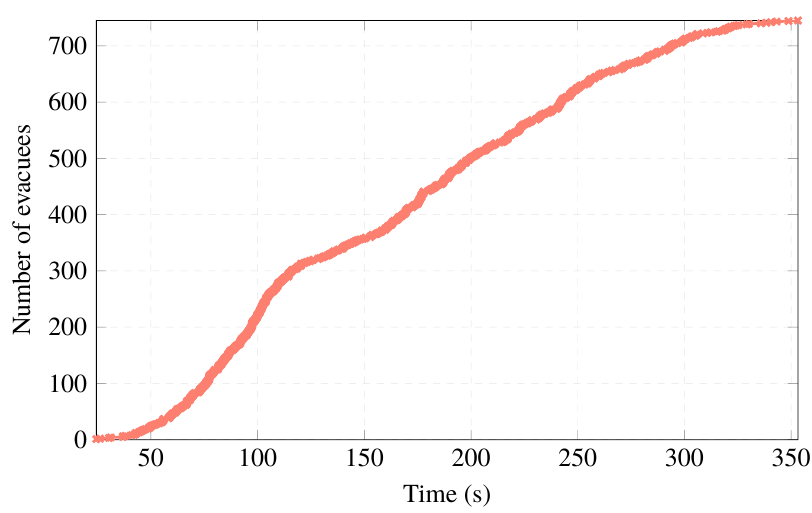
Figure 12. Dispersion diagram, abandonment time per number of evacuees (3 TW,